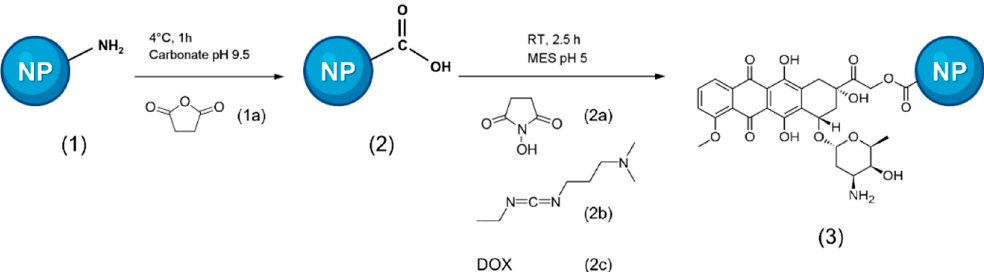
Scheme 1. Schematic pathway for the synthesis of doxorubicin-fluorescent silica nanoparticles in MES buffer, pH 5. (1) Fluorescent SiNPs (amine functionalization); (1a) Succinic anhydride; (2)